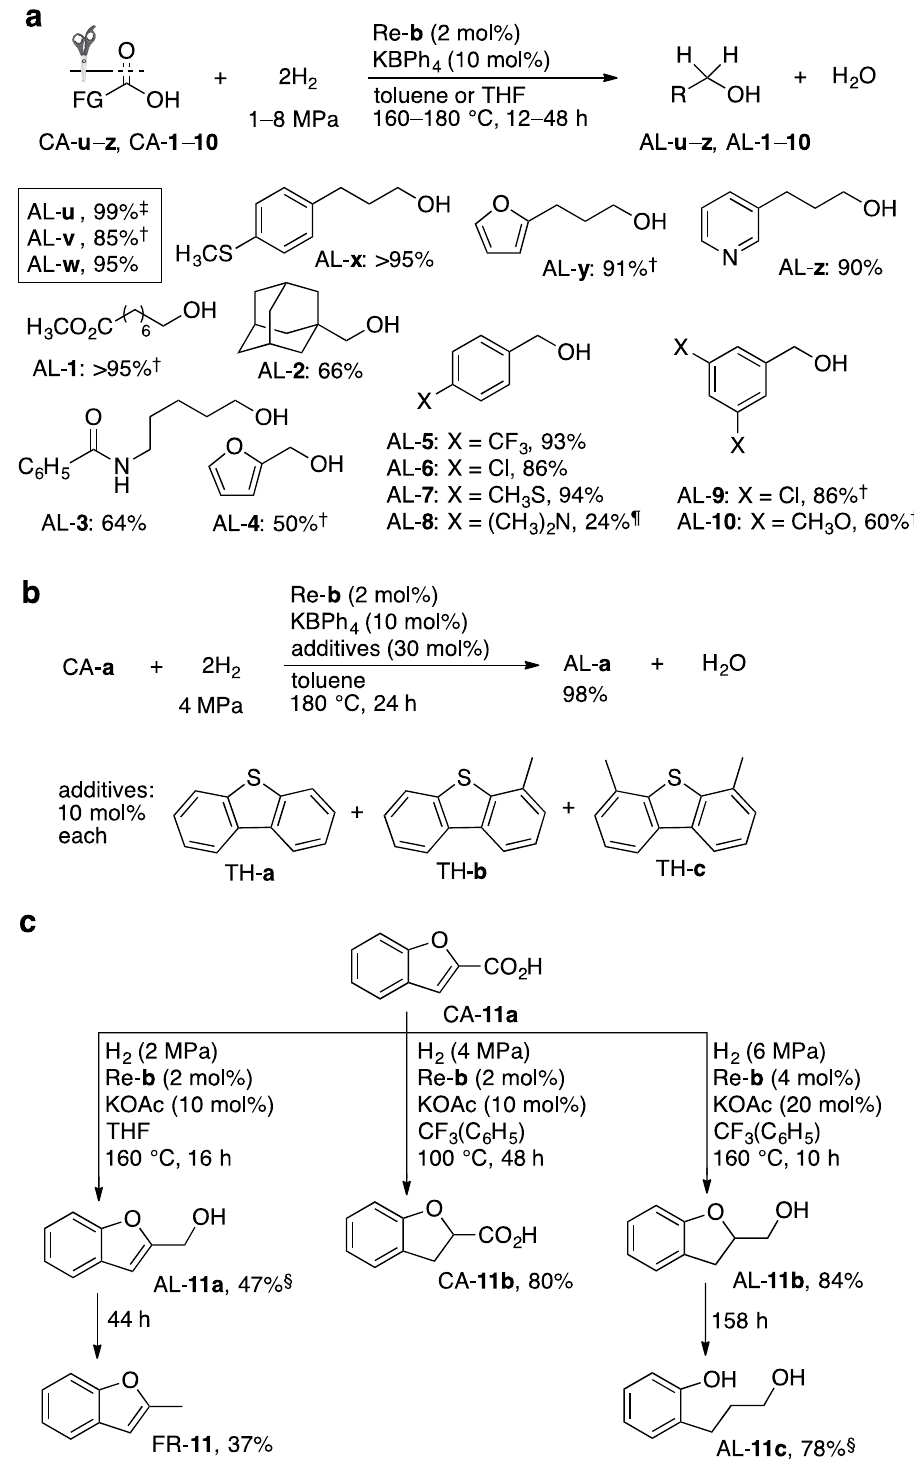
Figure 3. Improved chemoselective hydrogenation of CAs and hydrogenolysis of the resulting α -alkoxy alcohols using Re-b. See Supplementary Tables 6–10 for experimental details. ( a ) Substrate scope for the catalytic hydrogenation of CAs using Re- b . Unless otherwise noted, the corresponding esters were obtained in ≤ 5%. † THF was used instead of toluene. ‡ Isolated yield: 83%. ¶ Ester ES- 8 (~11%) was also obtained. ( b ) Re V -catalyzed CA hydrogenation in the presence of typical sulfur-containing substances generated by hydrodesulfurization during the refinement process of mature oil. c . Selective hydrogenation of CA- 11a and further hydrogenolysis. Yields (%) are based on CA- 11a . § AL- 11b (16–20%) was also